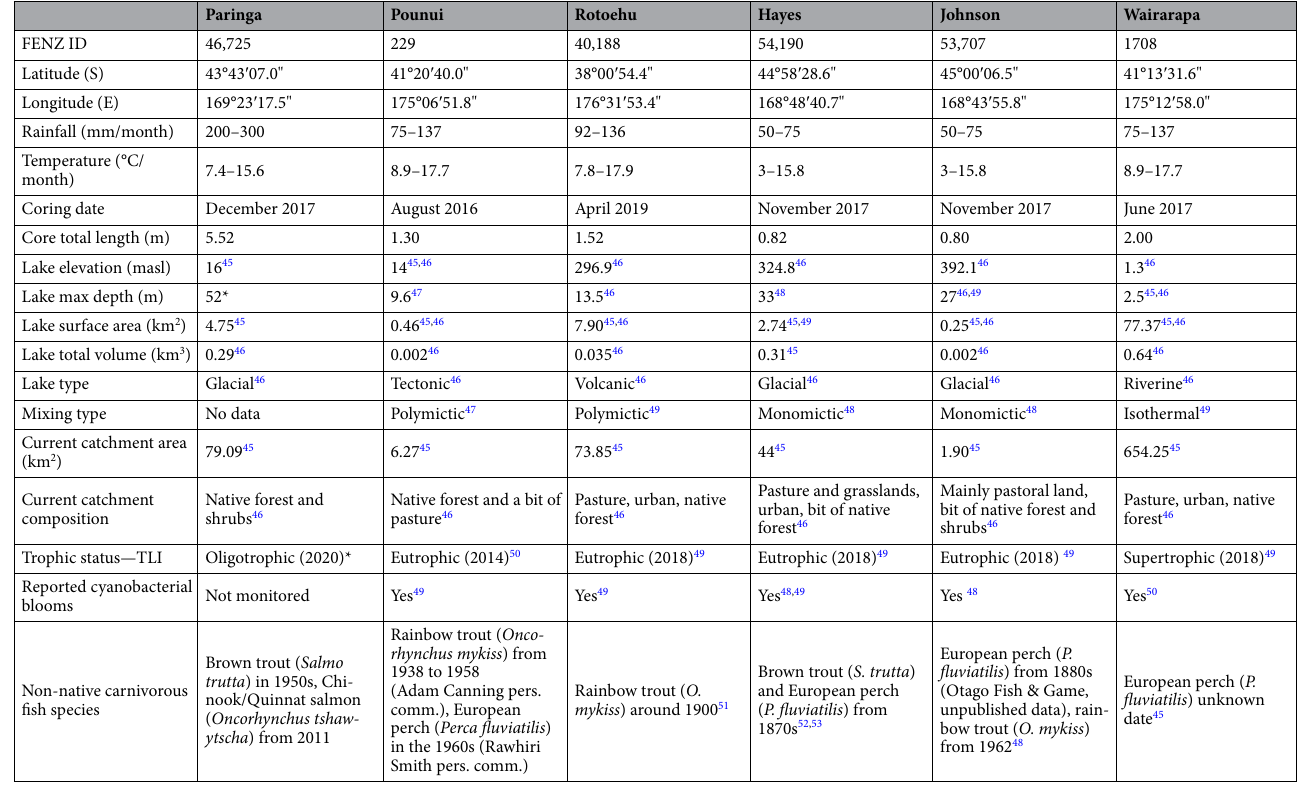
Table 1. Lake characteristics. Note that the FENZ ID is related to the Freshwater Ecosystems of NZ (FENZ) geo-database, and the Trophic Level Index (TLI) is based on total nitrogen, total phosphorous, water clarity, and chlorophyll-a. Rainfall and temperature values are the highest and lowest mean monthly values over one year, data from NIWA 54 . Lakes are ordered from left to right by increasing lake trophic status. *Lakes380 unpublished